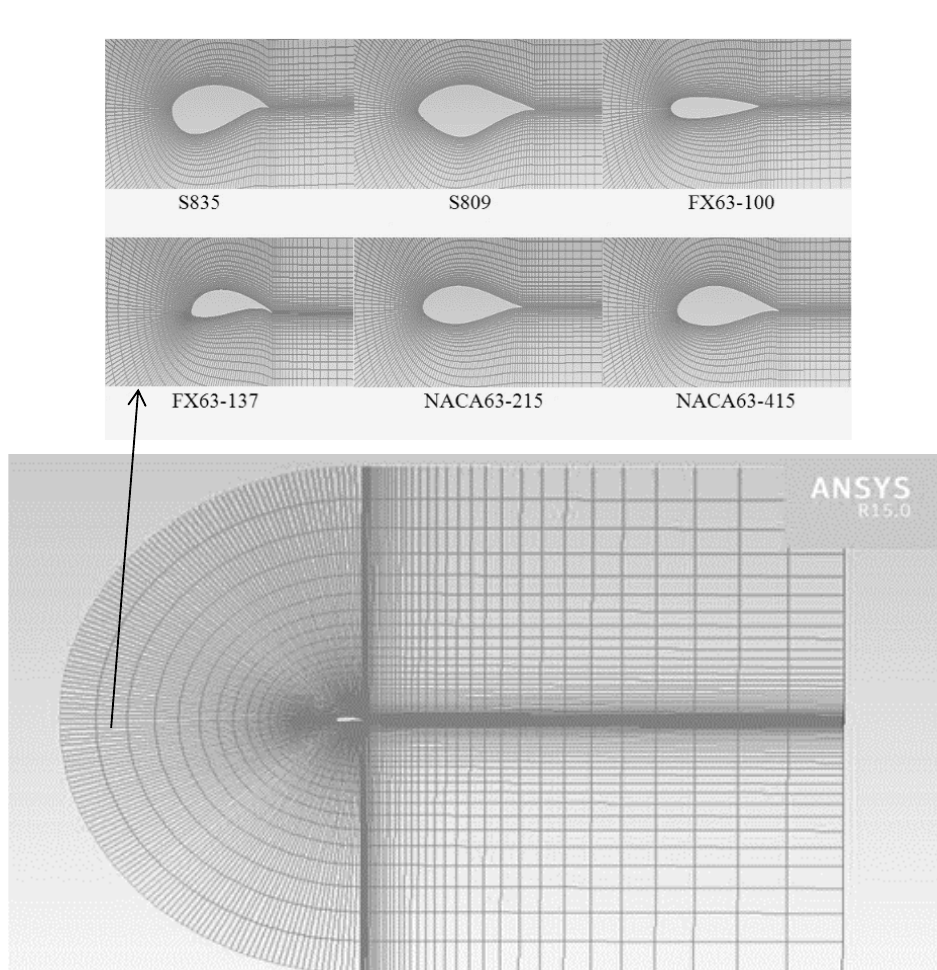
Figure 3. Mesh around airfoil.